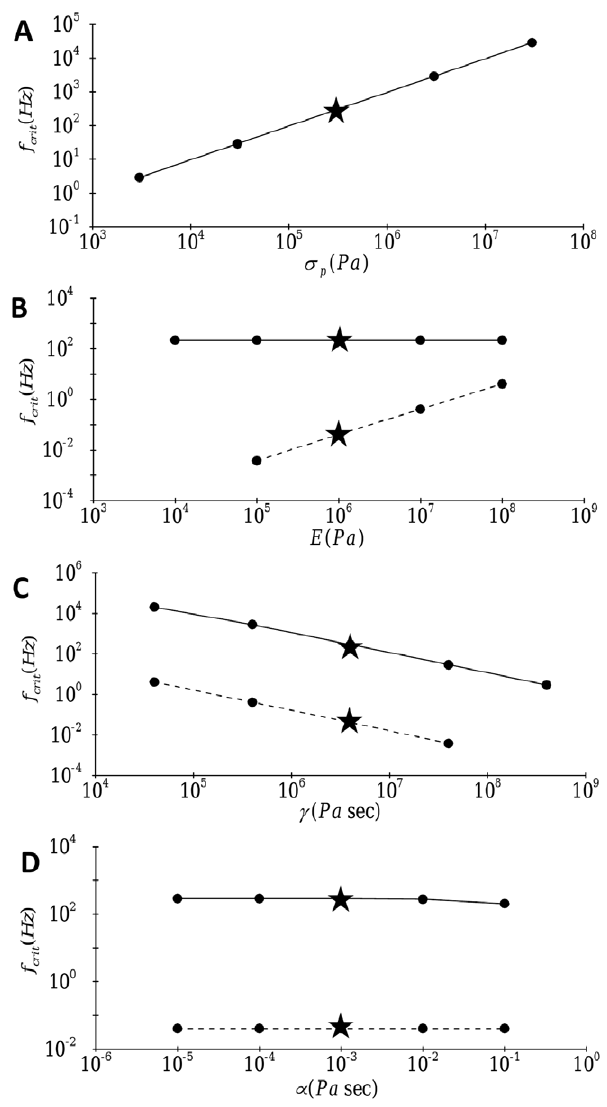
Figure 5. Time trace of oscillatory forcing (- - - -) and the resulting deformation-related stress (––––) at the nucleus: ( A ) transverse motion with f ~ 1000 Hz ; ( B ) axial motion with f ~ 1 Hz .